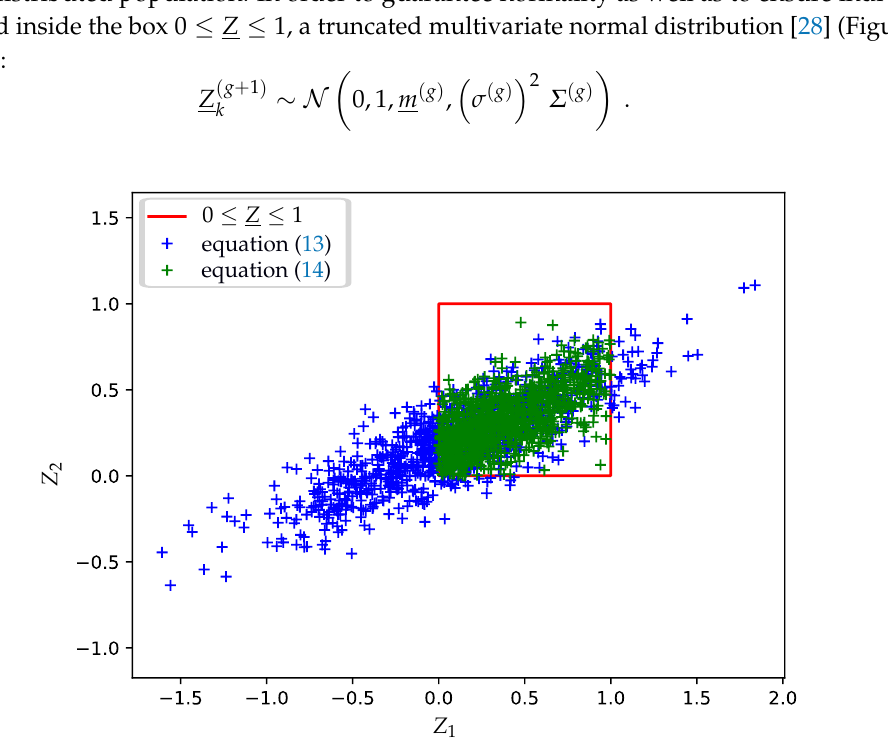
Figure 2. Samples generated from a truncated bivariate normal